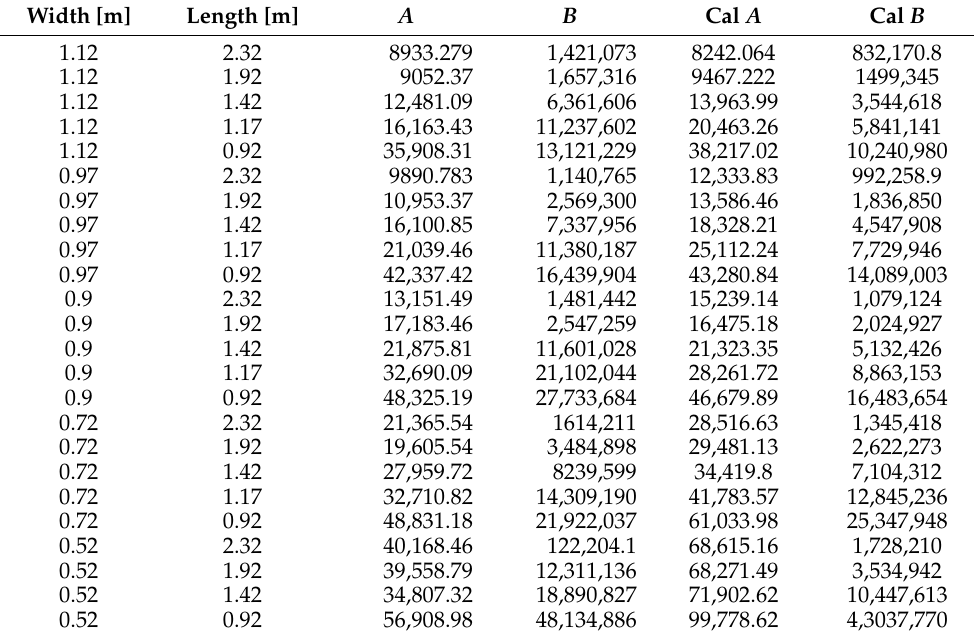
Table A7. The 16 mm plate Polygal vacuum tests A , B and theory calculated A , B